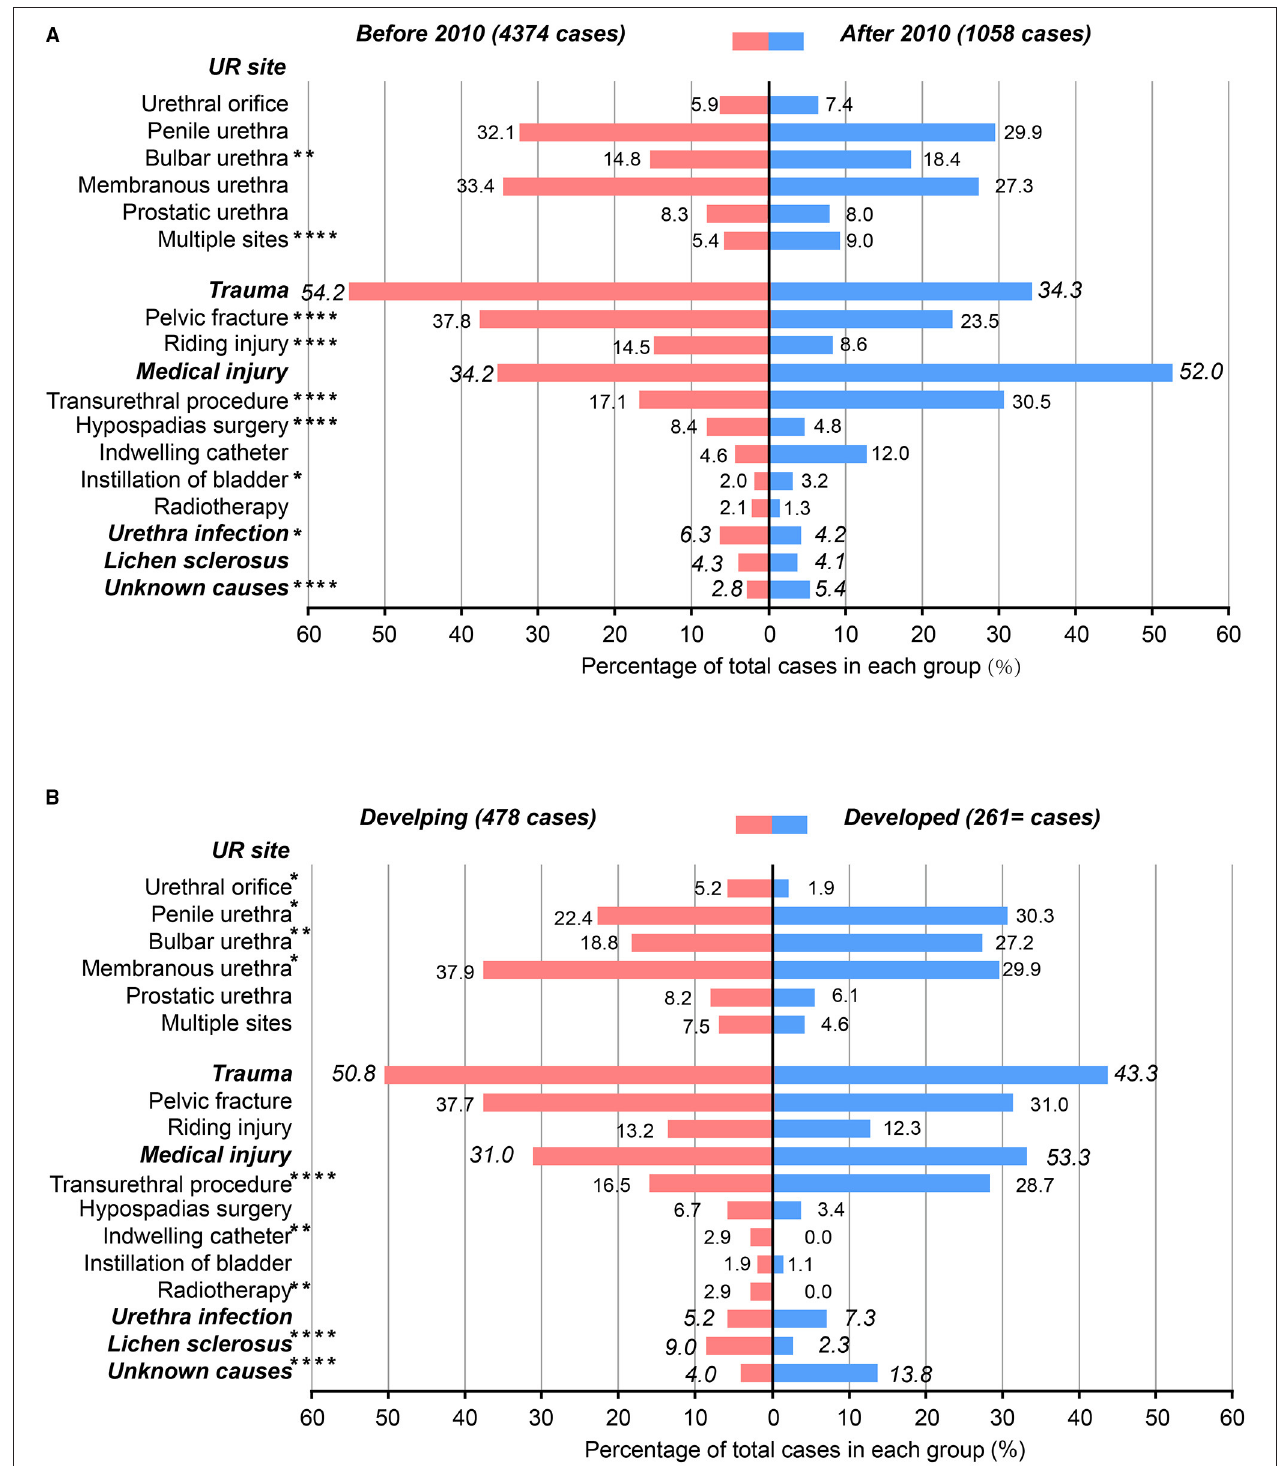
FIGURE 1 | Characteristics of the included male patients with urethral stricture. (A) The patients were grouped by treatment time; (B) the patients were grouped by developing and developed regions. * = p < 0.05; ** = p < 0.01; *** = p < 0.001; **** = p < 0.0001.